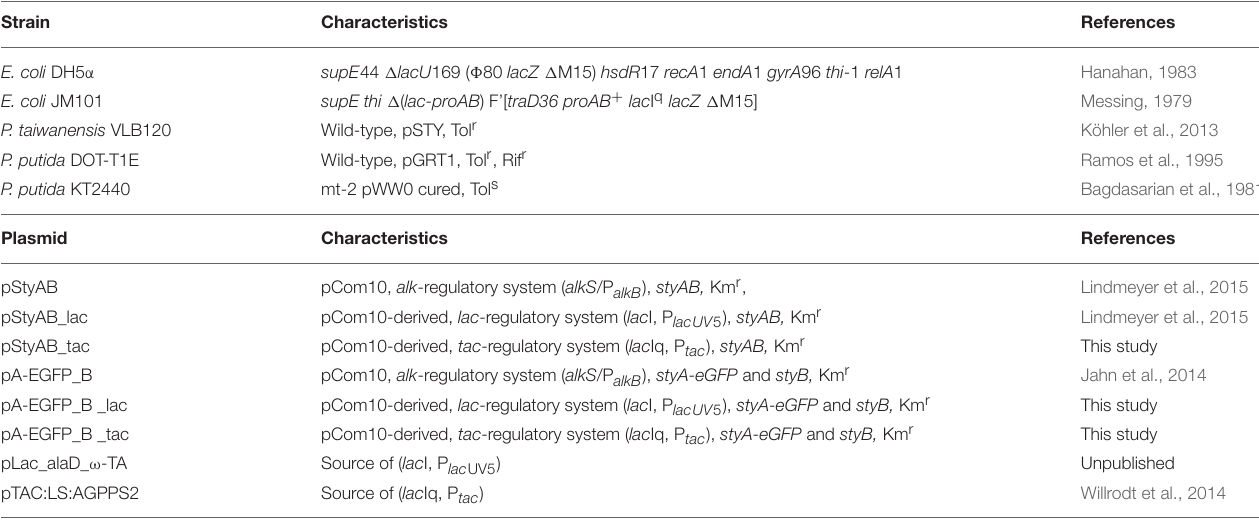
TABLE 1 | Bacterial strains and plasmids